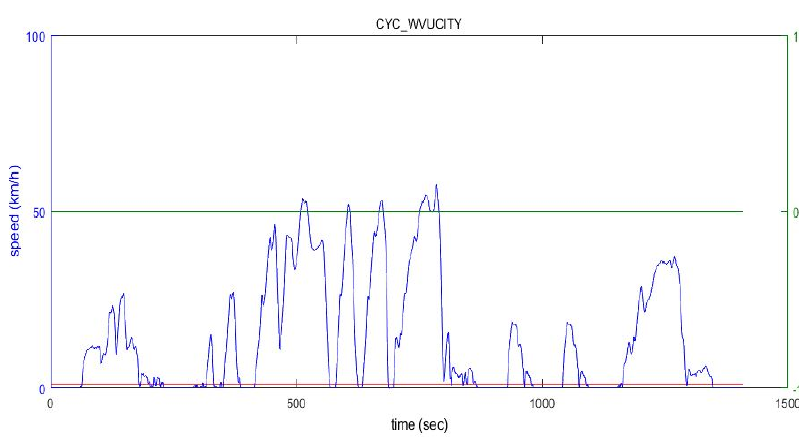
Figure 4. Speed profile of WVUCITY cycle. Table 15. WVUCITY cycle.